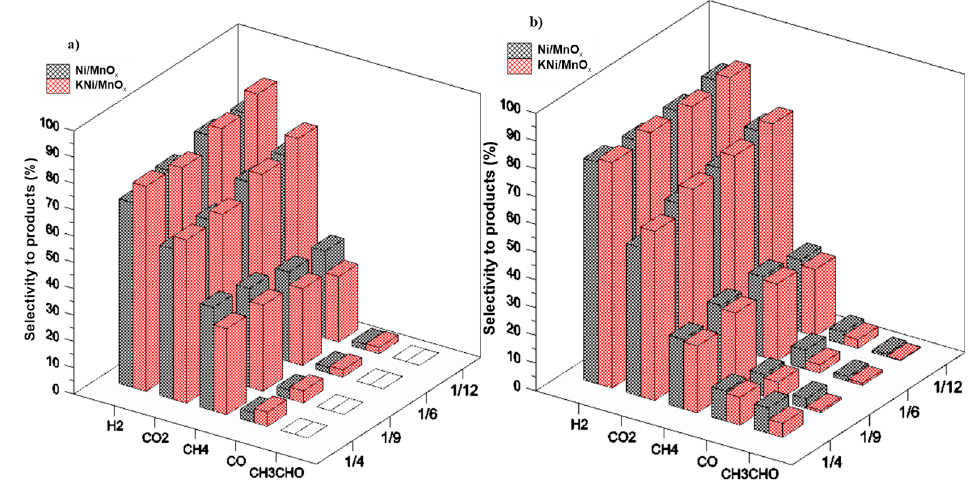
Figure 6. The selectivity to products ( a ) at the beginning and ( b ) after 18 h of SRE process at 420 °C for H 2 O/EtOH molar ratio of 12/1, 9/1, 6/1, and 4/1 over Ni/MnO x and KNi/MnO x